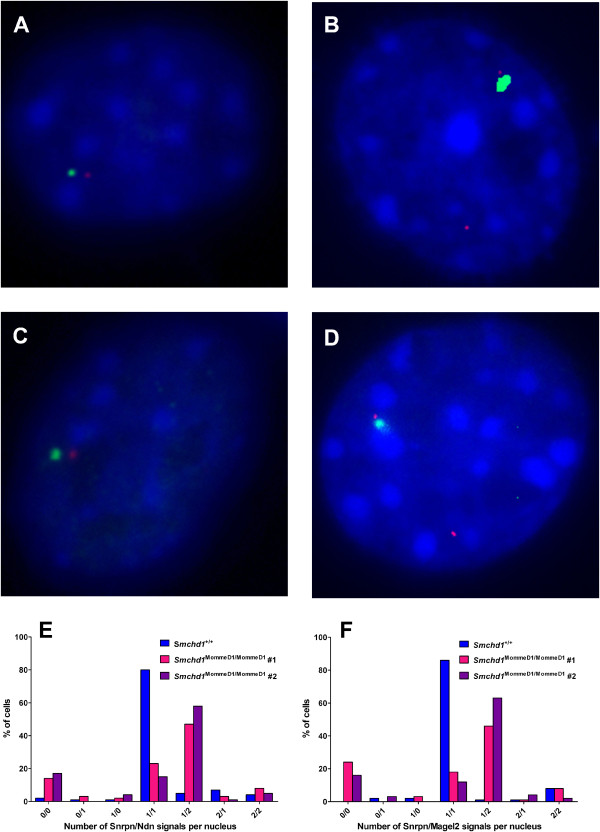
RNA-FISH showing biallelic expression of deregulated genes in the Snrpn cluster.Snrpn (green) and Ndn (red) RNA-FISH signals on (A)Smchd1+/+ and (B)Smchd1MommeD1/MommeD1 MEFs. Snrpn (green) and Magel2 (red) RNA-FISH signals on (C)Smchd1+/+ and (D)Smchd1MommeD1/MommeD1 MEFs. Images representative of the predominant hybridizing pattern for each genotype and gene combination are shown. The number of RNA-FISH signals per nucleus for (E)Snrpn/Ndn and (F)Snrpn/Magel2 were counted (100 randomly selected nuclei counted in each case) and plotted for each line of MEFs (Smchd1+/+, Smchd1MommeD1/MommeD1#1, and Smchd1MommeD1/MommeD1#2). The genotypes are indicated in each case.